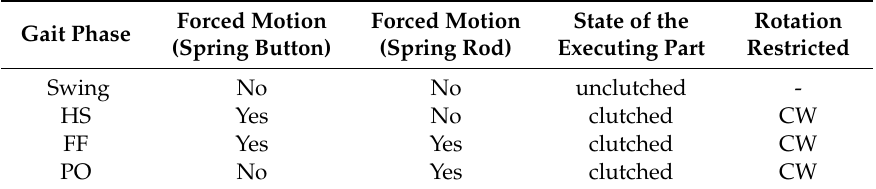
Table 1. State of the clutch during di ff erent gait